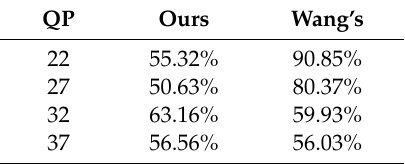
Table 7. Security experiment results against Wang et al.’s